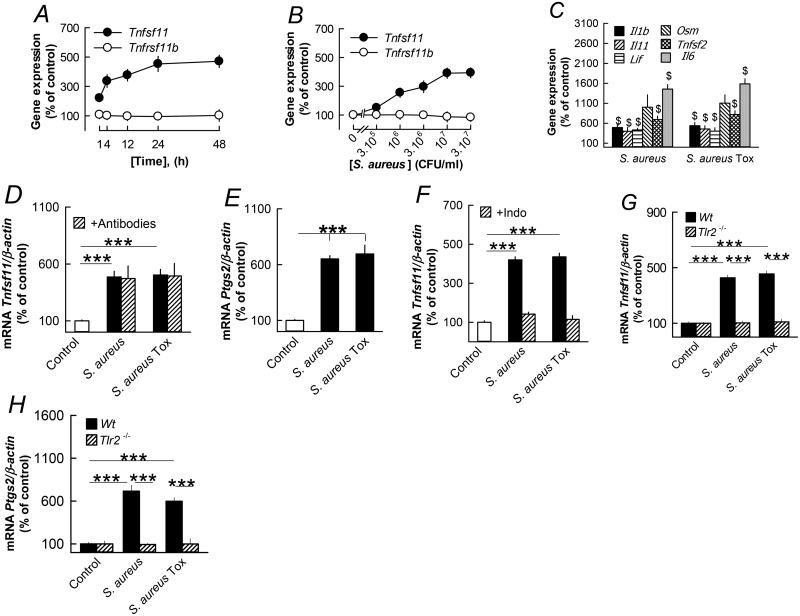
S. aureus stimulates RANKL in isolated mouse calvarial osteoblasts independent on cytokine but dependent on prostaglandin productions and TLR2.(A) S. aureus time-dependently stimulated Tnfsf11 mRNA without affecting Tnfrsf11b mRNA in mouse osteoblasts. (B) Concentration-dependent stimulation of Tnfsf11 mRNA, with no effect on Tnfrsf11b mRNA, by S. aureus (3x106 CFU/ml). (C) S. aureus (3x106 CFU/ml) upregulated the mRNA expression of Il1b, Il11, Il6, Lif, Osm and Tnfsf2 in osteoblasts. (D) The stimulatory effect by S. aureus (3x106 CFU/ml) on Tnfsf11 mRNA expression in osteoblasts was unaffected by adding a mixture of antibodies neutralizing IL-1β, IL-6, IL-11, LIF, OSM and TNF-α. (E) S. aureus (3x106 CFU/ml) stimulated Ptgs2 mRNA in mouse osteoblasts. (F) Indomethacin (1 μmol/l) abolished Tnfsf11 mRNA in osteoblasts induced by S. aureus (3x106 CFU/ml). (G, H) The stimulatory effect by S. aureus (3x106 CFU/ml) on Tnfsf11 and Ptgs2 mRNA was observed in osteoblasts from wild type mice but not from Tlr2 deficient mice. Data are means of 5 observations and SEM is given as vertical bars when larger than the radius of the symbol. In Fig 4A, effects on Tnfsf11 mRNA were statistically significant at 1–48 h (P<0.001). In Fig 4B, effects on Tnfsf11 mRNA were statistically significant at 106 and 3x106 (P<0.01) and at 107 and 3x107 (P<0.001) CFU/ml. ***P<0.001 compared to unstimulated control (D-G) or to S. aureus stimulated osteoblasts (G).